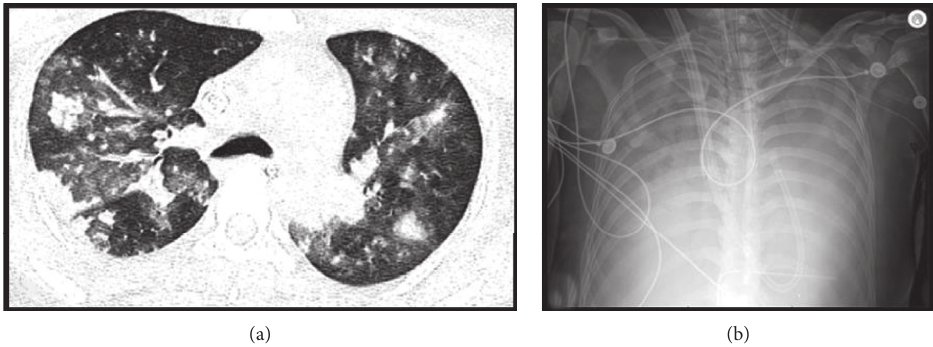
Figure 1: (a) High-resolution computed tomography with centrilobular and peripheral consolidation and surrounding ground-glass opacities compatible with pulmonary hemorrhage. Small basilar dependent pleural effusions were also present (not pictured). (b) Chest radiography showing near complete opacification of the lungs in the setting of diffuse alveolar